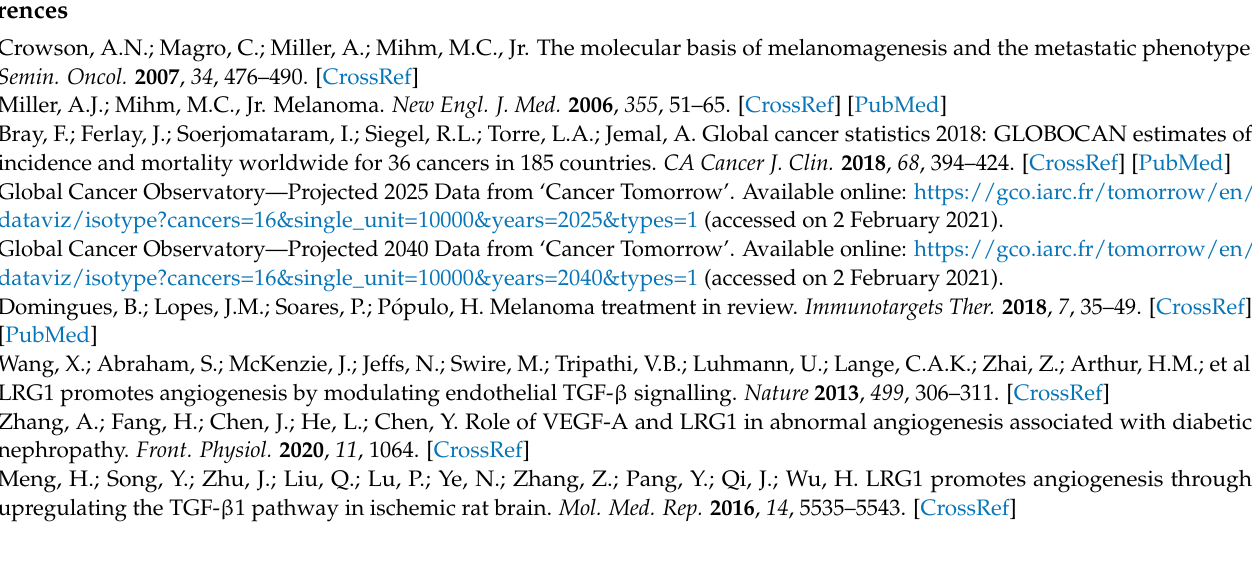
Figure S2: LRG1 promotes A375 cell invasiveness in vitro, Figure S3: Gene silencing efficiency of LRG1 siRNA in